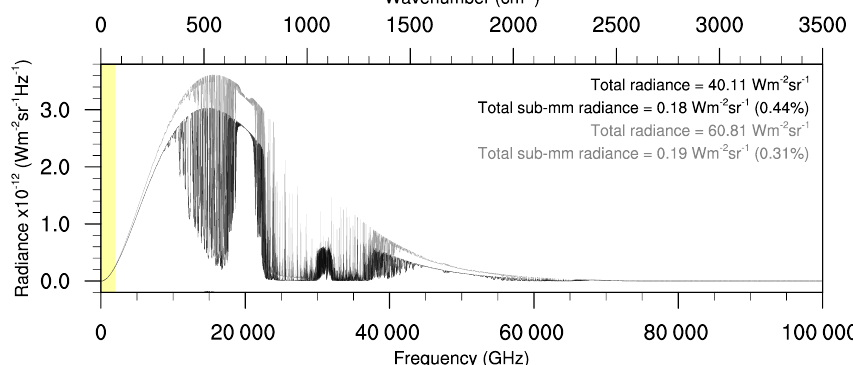
Figure 1. The simulated downwelling spectral radiance (zenith angle=0 ◦ ) received at the Earth’s surface over the entire longwave range (1 GHz sampling resolution). The submillimetre region (10–2000GHz) is shaded in yellow. Calculations for two polar locations are shown: a high, dry Arctic case (Summit, Greenland – 3216ma.m.s.l., black) and an Antarctic coastal case just above sea level (Rothera, Antarctica – 16ma.m.s.l., grey). For full details of the simulations see Sect.